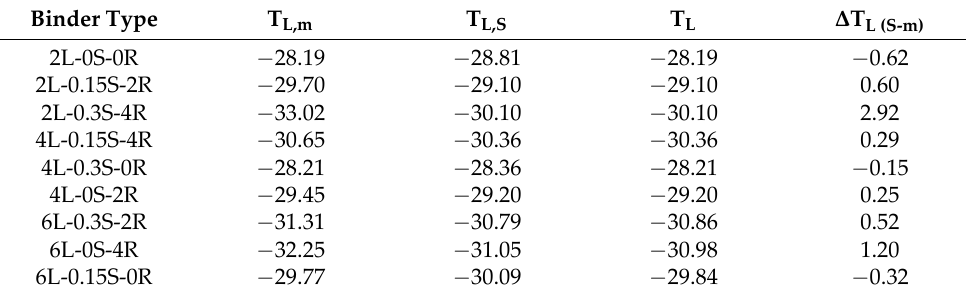
Table 6. PG Low temperature of BBR test for all tested